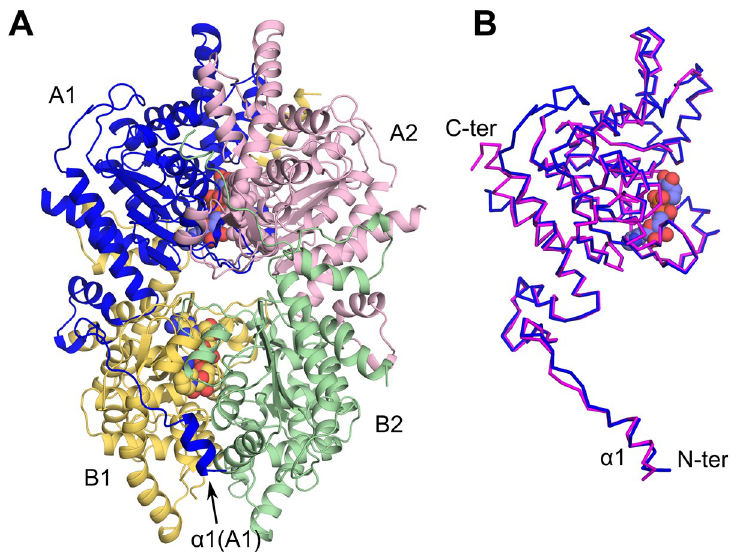
Fig 2. Overall structure of NAD + -bound BmDHS. (A) Cartoon representation of the BmDHS tetramer. Individual protomers within the tetramer are depicted in different colors (A1—blue, A2—pink, B1—yellow, and B2—green). NAD + molecules are shown in a sphere representation. (B) Superposition of a BmDHS protomer (A1 in blue; same orientation as in panel A) onto its human counterpart (magenta).